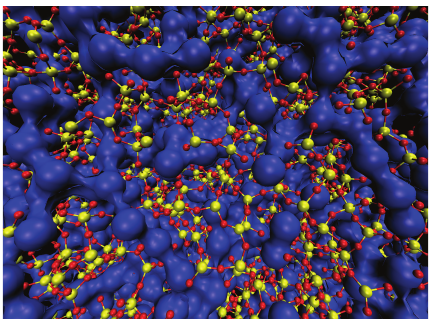
Figure 2: (Color online) Molecular dynamics snapshot of the structureofsodiumtrisilicateat2100Katthedensity 𝜌 = 2.2 g cm −3 . The big blue spheres that are connected to each other represent the Na atoms. The Si–O network is drawn by yellow (Si) and red (O) spheres that are connected to each other by covalent bonds shown as sticks between Si and O spheres (from [5], by permission).